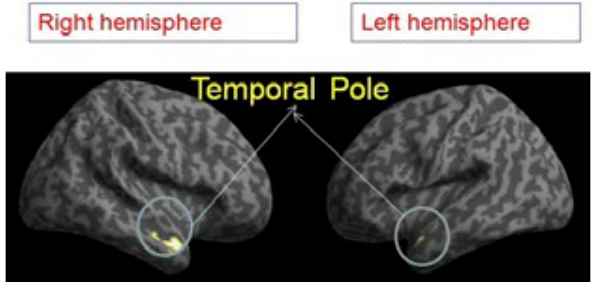
Figure 10. Influence of negation on Human Brain. Distinct neural regions for negative sentences: Temporal Pole: This region is associ- ated with anxiety and depression.